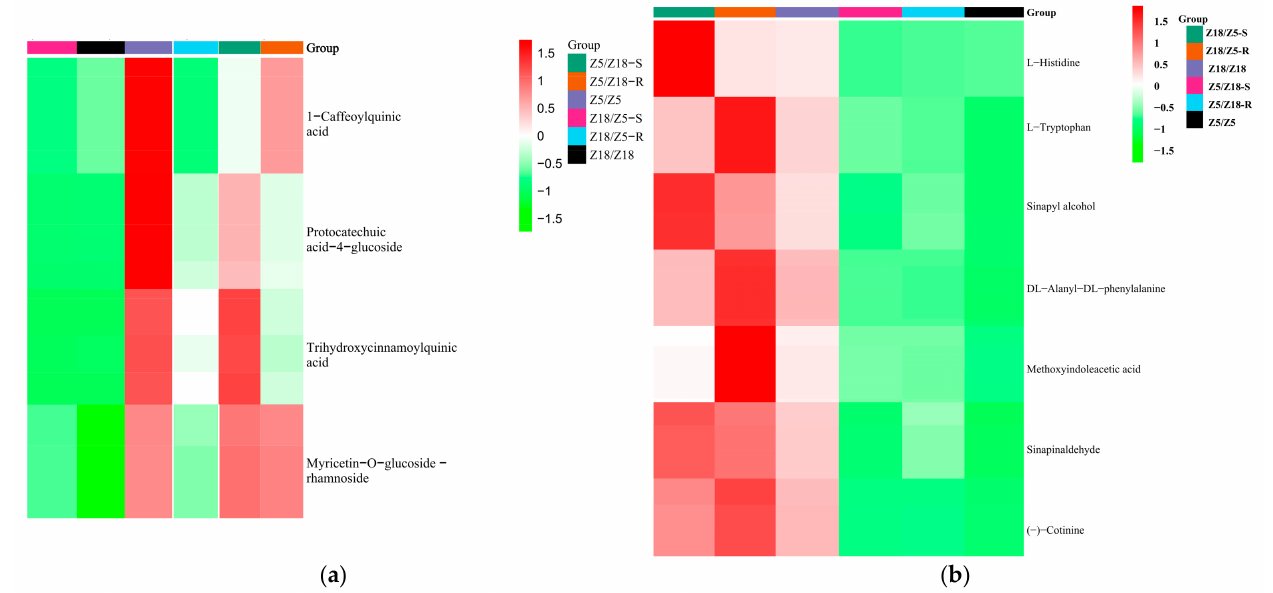
Figure 4. Clustered heat maps of long-distance transport metabolites associated with early-maturity ( a ) and late-maturity ( b ) traits in potato plants: ( a ) long-distance transport metabolite associated with early-maturity potatoes; ( b ) long-distance transport metabolites associated with late-maturity potatoes. Z5/Z18-S: Z5 stems of Z5/Z18 grafts. Z5/Z18-R: Z18 stems of Z5/Z18 grafts. Z18/Z5-S: Z18 stems of Z18/Z5 grafts. Z18/Z5-R: Z5 stems of Z18/Z5 grafts. Z5/Z5: stems of Z5/Z5 grafts. 18/Z18: stems of Z18/Z18 grafts. Metabolites accumulated level by color: red indicates up, green represents down. Table 4. KEGG pathway of seven mobile metabolites related to the late-maturity traits in potato plants. Metabolites Class The KEGG Pathway L-histidine Amino-acids and derivatives Histidine metabolism L-tryptophan Amino-acids and derivatives Tryptophan metabolism DL-alanyl-DL-phenylalanine Amino-acids and derivatives N/A Sinapyl alcohol Phenolic acids Phenylpropanoid biosynthesis Sinapinaldehyde Phenolic acids N/A (-)-Cotinine Alkaloids N/A Methoxy indole acetic acid